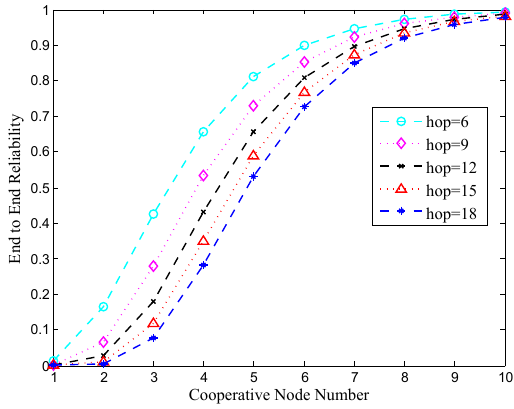
Figure 4. Impact of k and hop on ETE